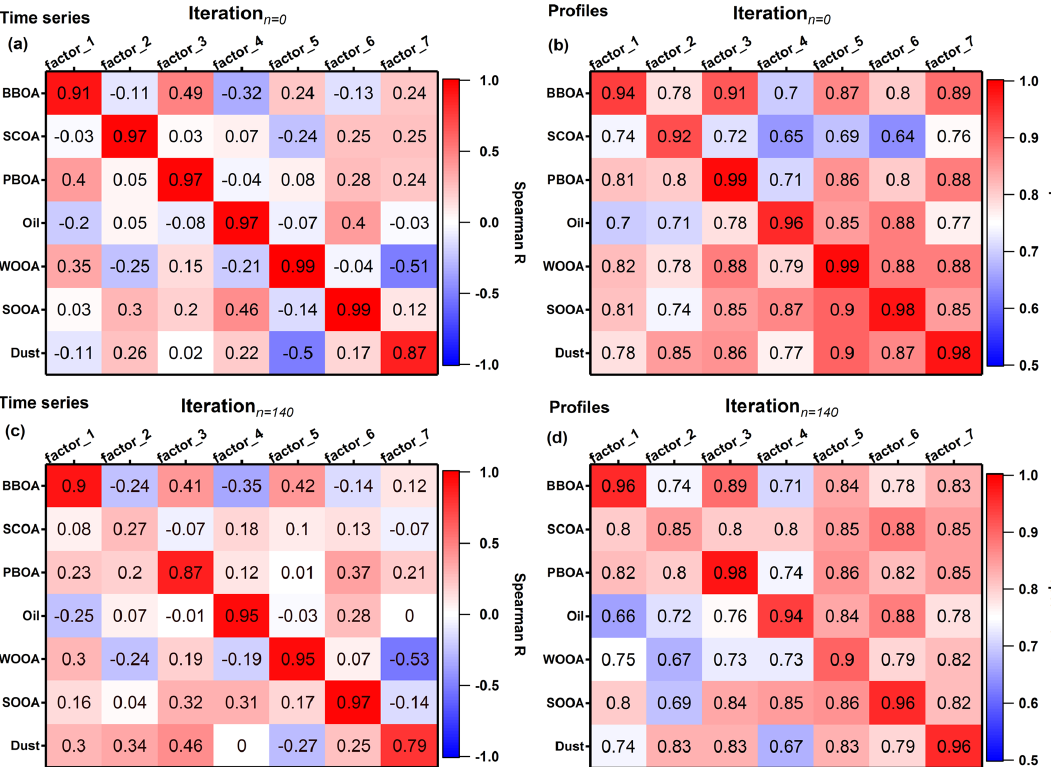
Atmos. Chem. Phys., 19, 7279–7295, 2019